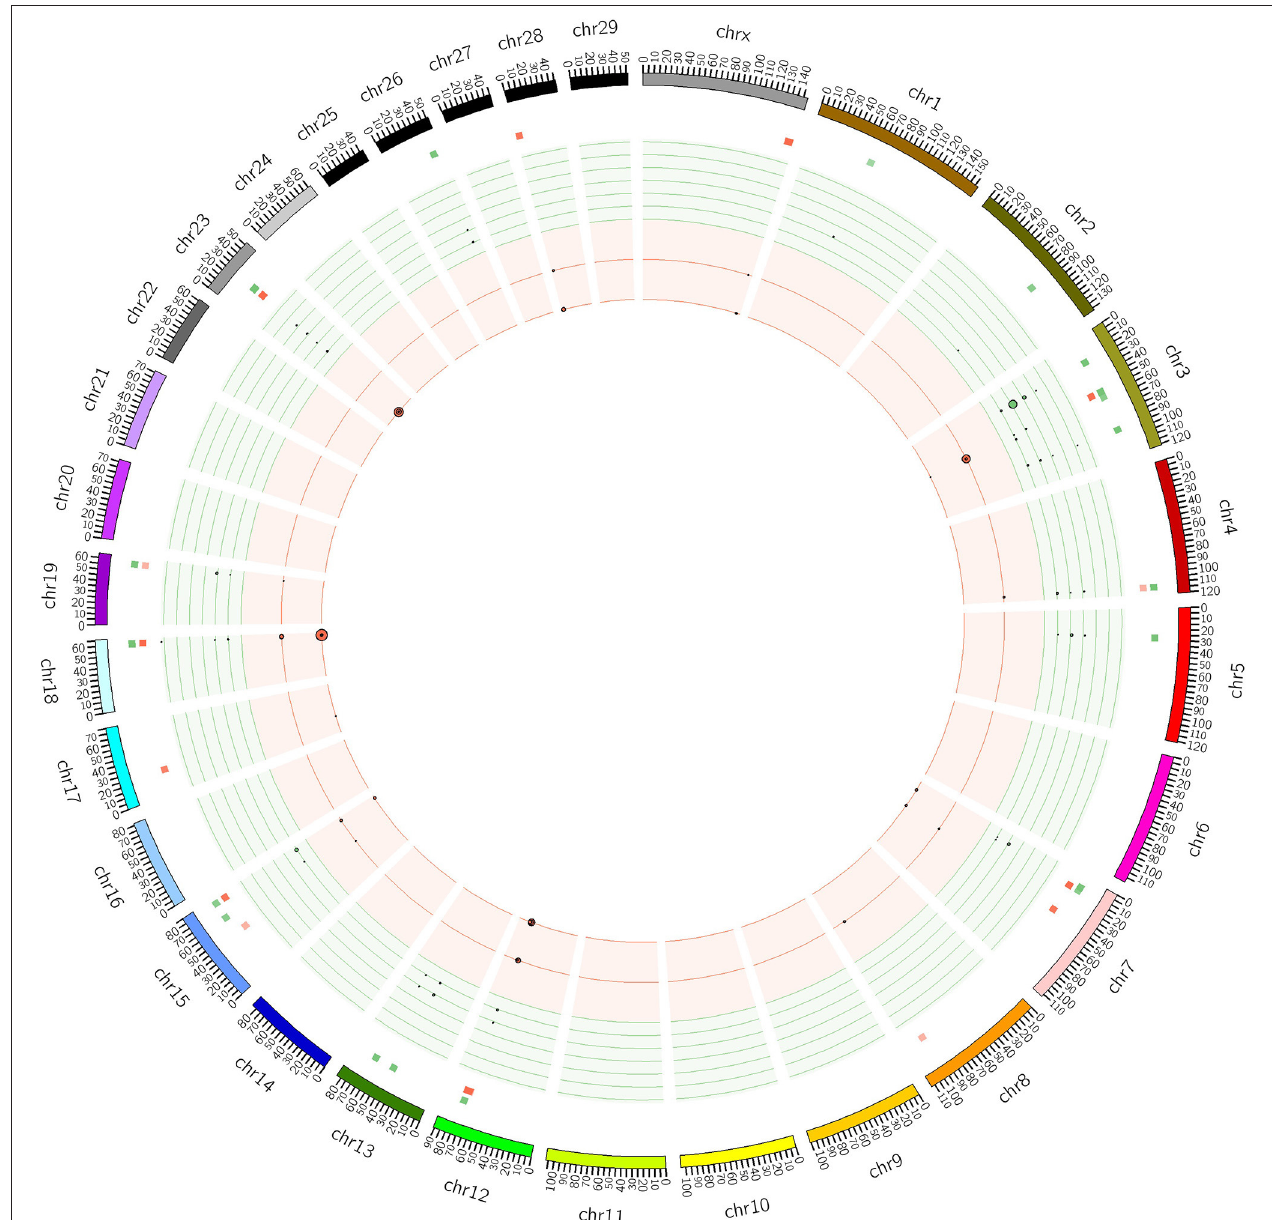
FIGURE 1 | CNVRs in GPE bulls. Plot shows the CNVRs identified from the 175 sequenced GPE bull genomes in Circos format (Krzywinski et al., 2009). The outer ideogram runs clockwise from chromosome 1 to chromosome X with labels in Mb of physical distance. The copy number data is represented in the inner tracks. The two innermost tracks show scatter plots of the CNVRs, where the red track shows copy number loss and the green track shows copy number gain. The size of the dot in the scatter plot is proportional to the number of samples containing the CNVR. The other track shows a heat map which indicates the parts of the genome that contain copy number gain and loss. This plot simply collapses the scatter plot values onto a single radial